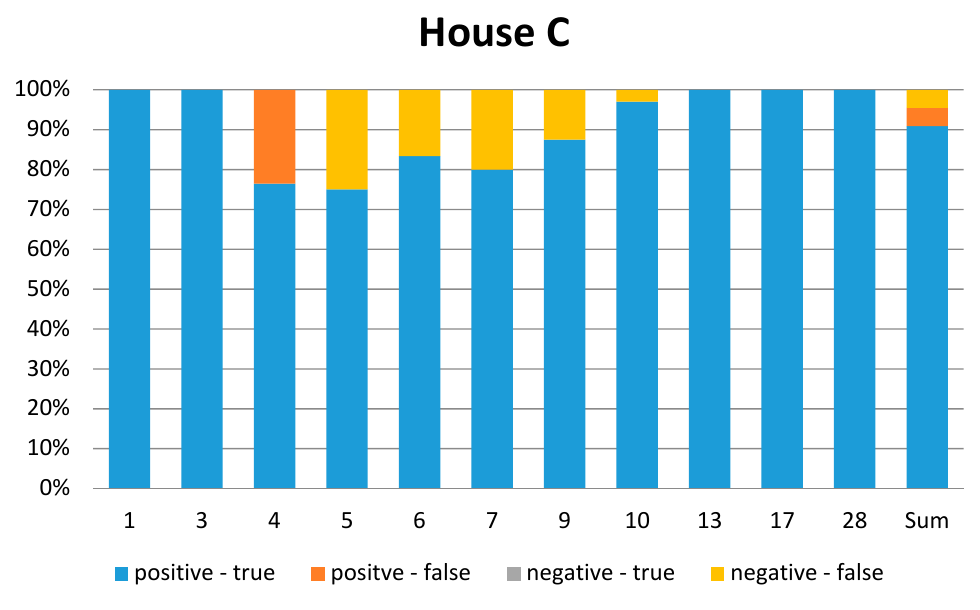
Figure 9. Graphical representation of the confusion matrix for House C. Each bar represents one ADL. (1 = leave house, 3 = eating, 4 = toilet, 5 = shower, 6 = brush teeth, 7 = toilet usage upstairs, 9 = shaving, 10 = sleep, 13 = prepare breakfast, 17 = drink, 28 = relax). The last bar represents the overall ADL. Table 3. Precision, recall, F-measurement and accuracy in % of House A in comparison with the benchmark (CRF).